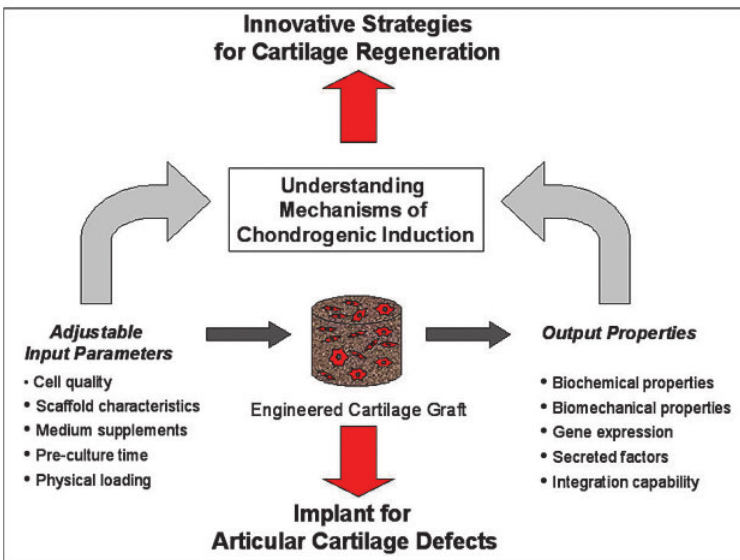
Outlook on the need for cartilage tissue engineering.The traditional purpose of gener- ating engineered cartilage is clearly the use as graft for the repair of articular cartilage defects (bottom red arrow). We propose that hypothesis-driven experiments on the cause-effect relationships between modulating parameters (left) and the resulting tis- sue properties (right) will help to understand general mechanisms of chondrogenesis critical for cartilage development and regeneration.This knowledge will lead to the de- velopment of innovative strategies for cartilage regeneration (top red arrow), possibly based on the recruitment of resident cells thanks to the combination of surgical tech- niques, smart materials and postoperative rehabilitation